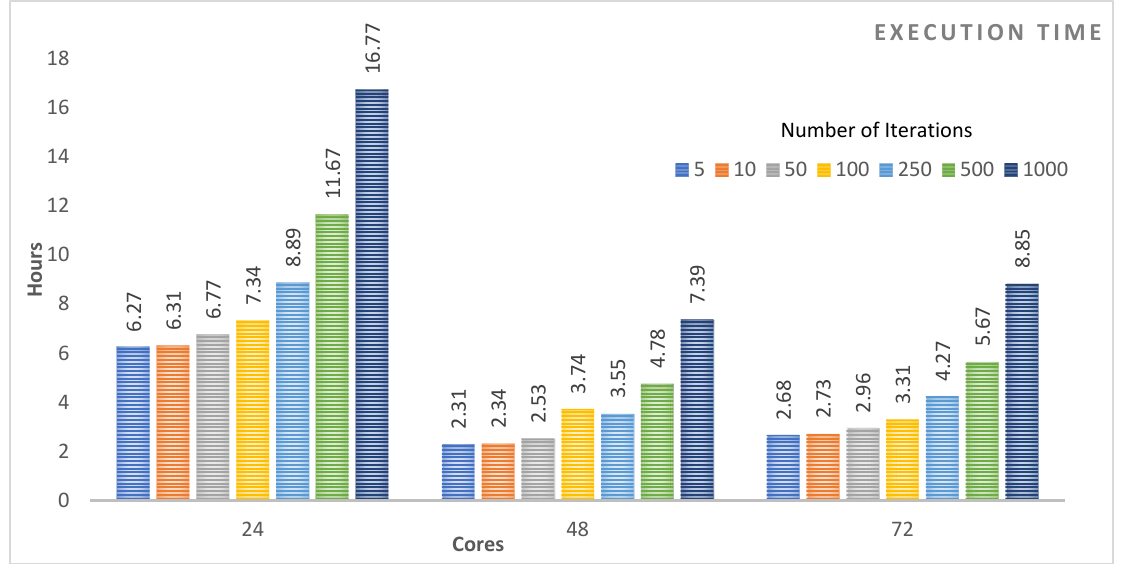
Figure 17. Execution time vs. number of cores for various numbers of LDA iterations (a limited number of features— 10,000 keywords).